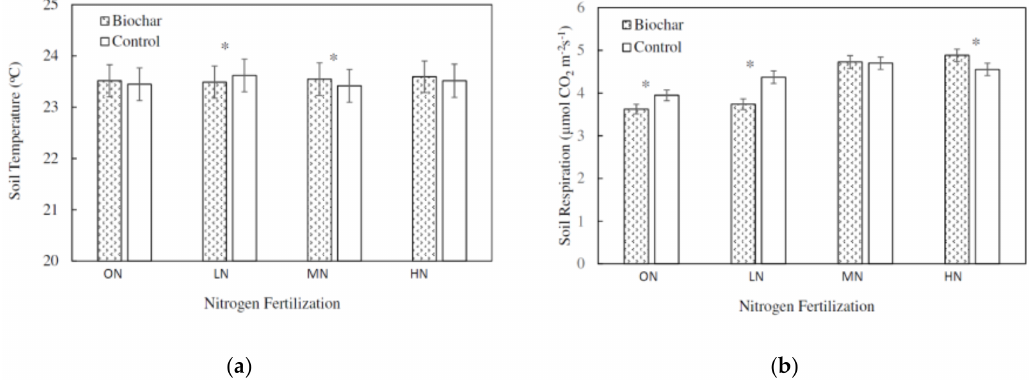
Figure 2. Effects of biochar addition on ( a ) soil temperature ( ◦ C) and ( b ) soil respiration ( µ mol CO 2 m − 2 s − 1 ) under different nitrogen fertilization levels. ON: 0 kg N ha − 1 ; LN: 17 kg N ha − 1 ; MN: 34 kg N ha − 1 ; and HN: 67 kg N ha − 1 . Each value is calculated from 80 pot measurements in two blocks. Error bars are standard errors of means. * indicates significant difference between no biochar and biochar addition at α = 0.05